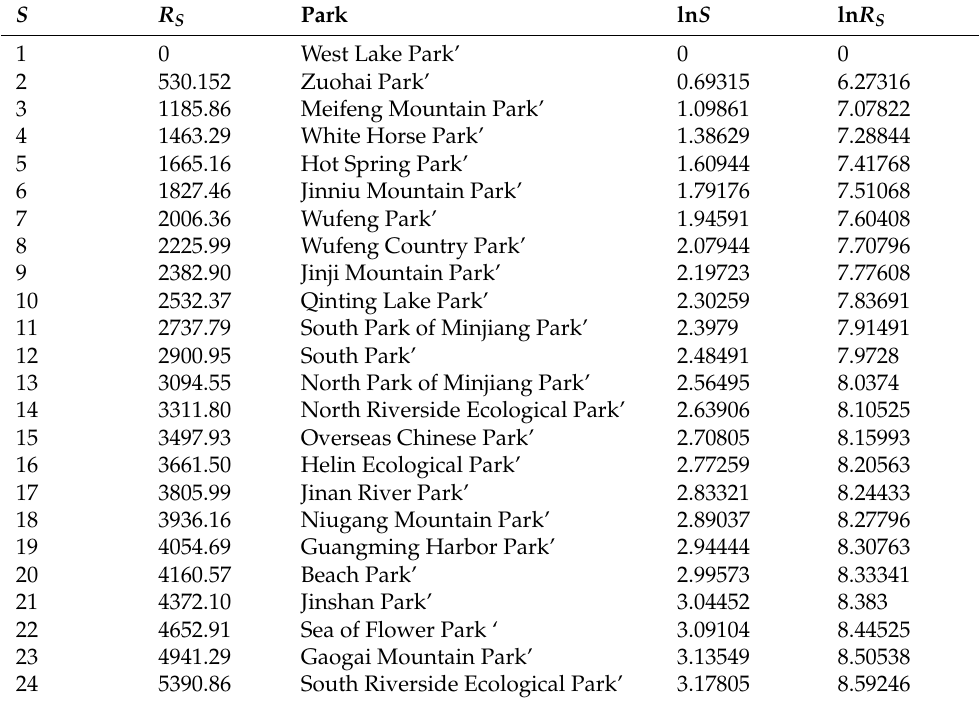
Table A5. Park system aggregation dimensions based on West Lake Park.